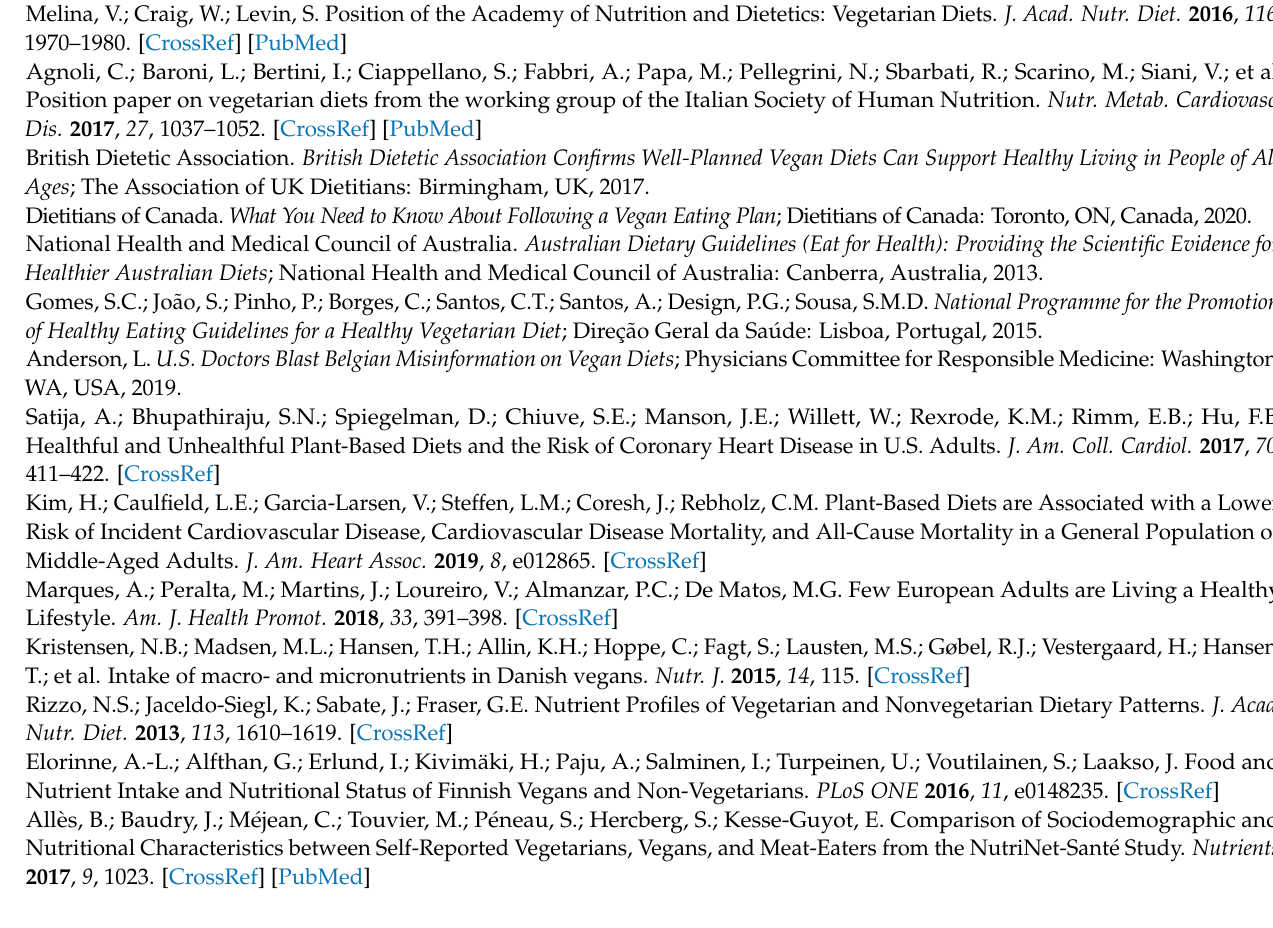
Figure S2: Proportion of macronutrients from supplementation, Figure S3: Proportion of micronutri- ents from supplementation, Table S1: Sociodemographic and other characteristics of participants, Table S3: Intakes of food groups in frequencies, Table S3: Transportation, everyday sitting, and PA of vegans and non-vegans, Table S4: Sleep quality and patterns of vegans and